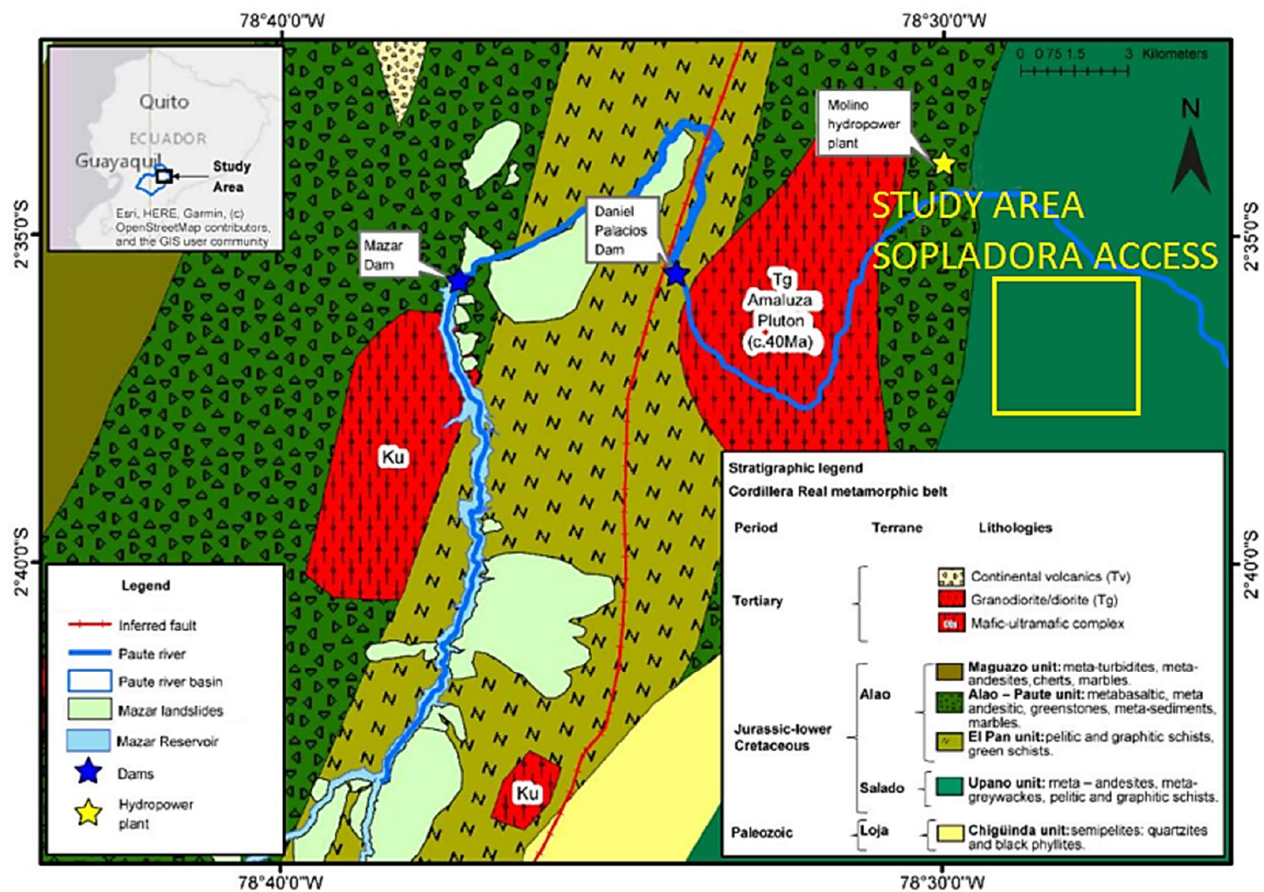
Figure 3. A regional geological map with the study area (the yellow square) showing the general trend of geologic materials and present formations. Modified from [44].